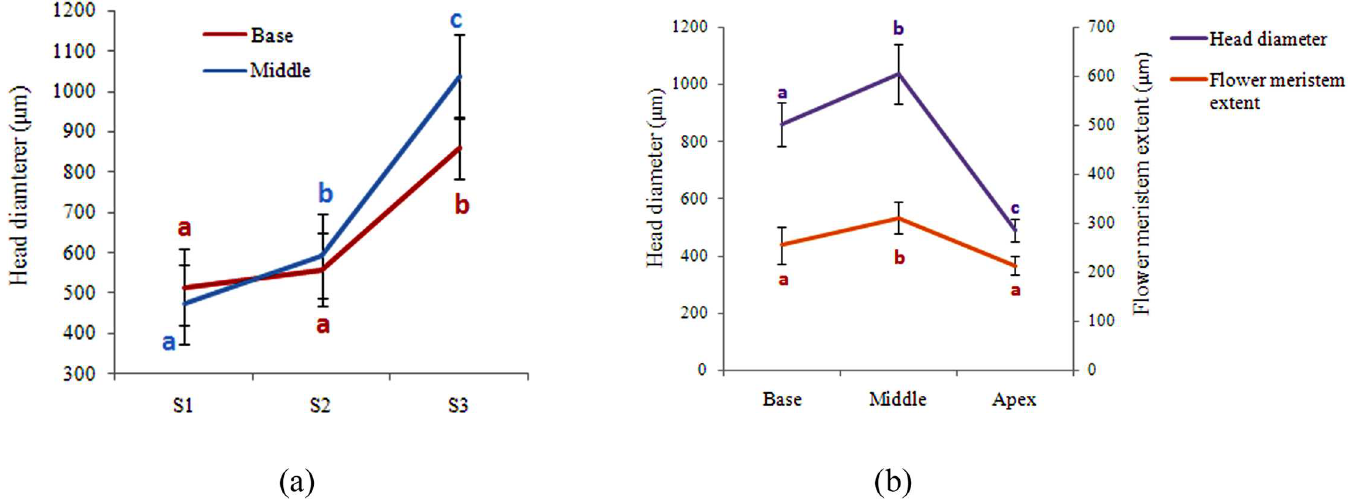
Fig 3. Quantitative changes during head development. (a) Head diameterat the basal and middle part in three developmental stages (S1, S2, S3); meristem expansionstarts earlier in the middlepart and shows a higherrate comparedto the basal part. (b) Comparisonof head diameterand flower primoridumsize in the basal, middleand apical zones of the heads in stage S3. The expansionof the head in the middle part is paralleledwith the promotion of the middle flowers (n = 10 per developmental stage). For each measuredtrait, characters that share the same letter do not differ significantly on the basis of Tukey’s test (p <